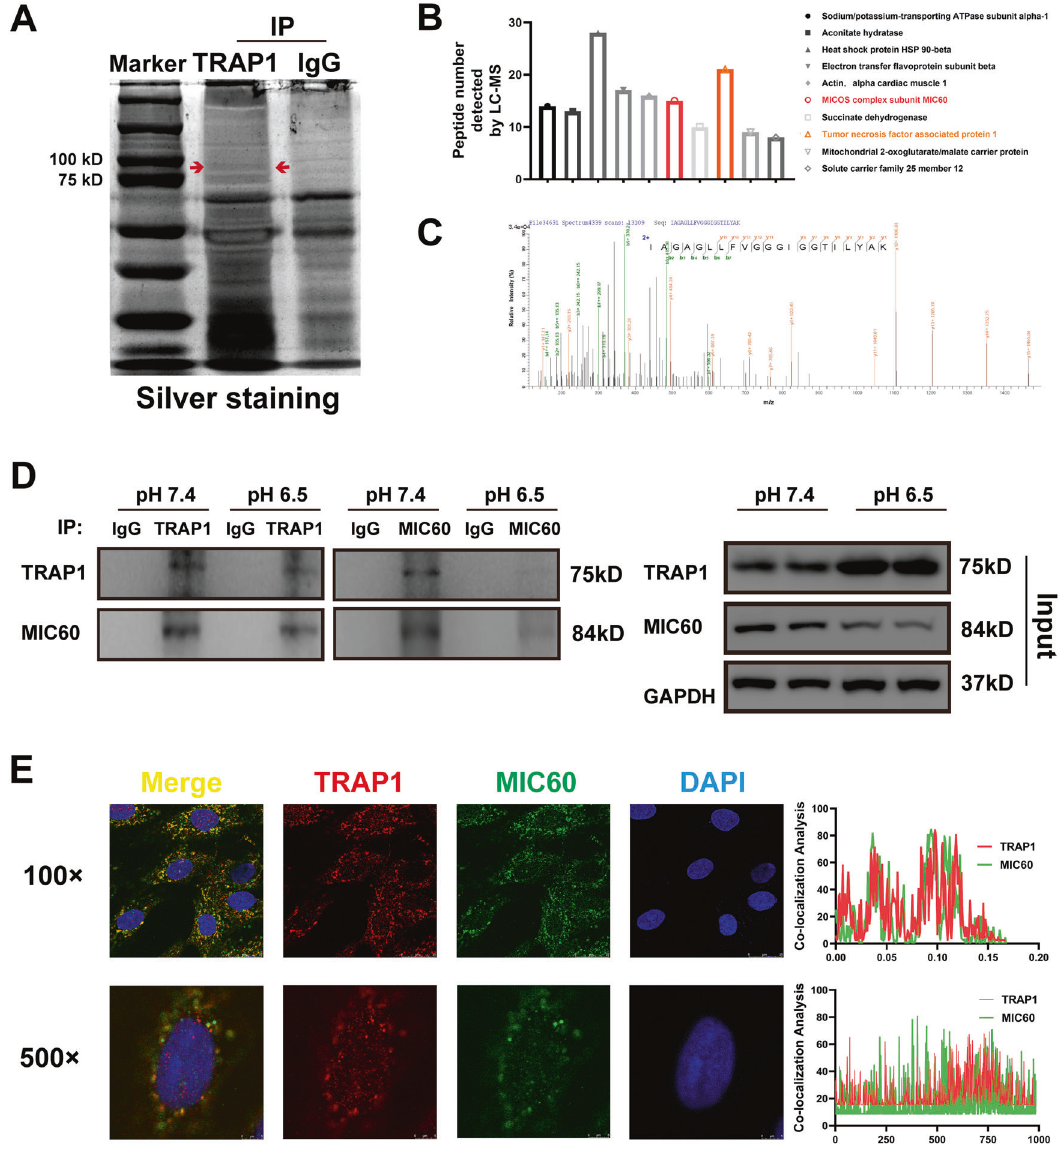
Fig. 1 TRAP1 directly interacted with MIC60 in H9C2 cells. A Silver staining of TRAP1 immunoprecipitates. B LC-MS/MS of TRAP1 immunoprecipitates. C Representative fragmentation spectrum of the identi fi ed MIC60 peptides. D Immunoblotting analysis of TRAP1 and MIC60 expression in a co-IP assay performed in H9C2 cells with anti-TRAP1 or anti-MIC60 Magnetic beads, respectively. E Detection of the colocalization of MIC60 (green) and TRAP1 (red) using confocal microscopy in H9C2 cells. Nuclei were stained using DAPI (blue), (Scale bars, 25 um). Data were the means ± SD from three independent